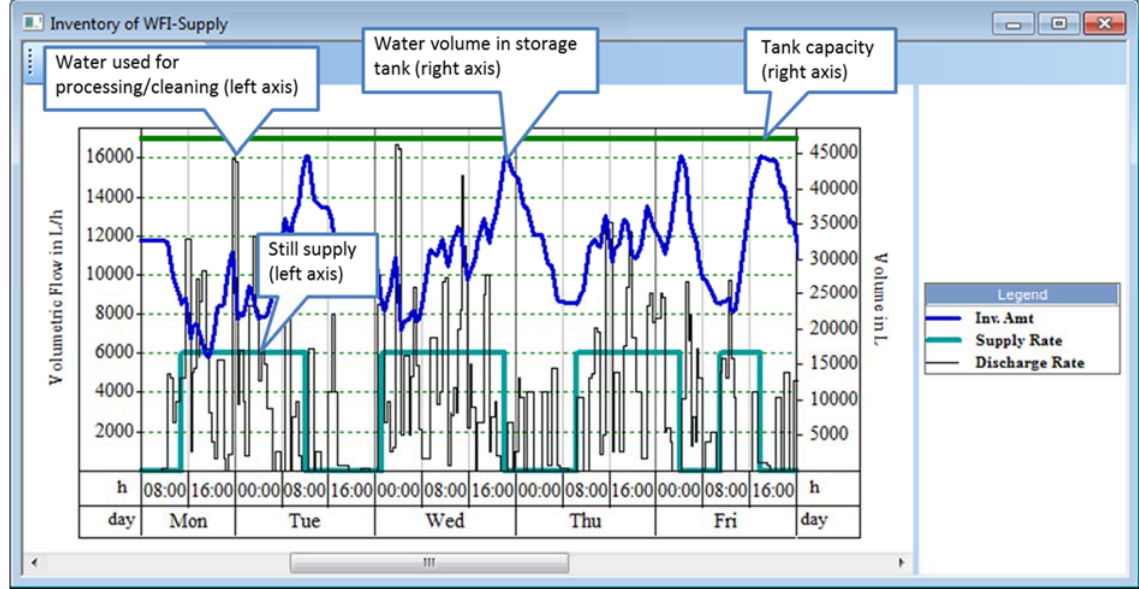
Figure 14. WFI system